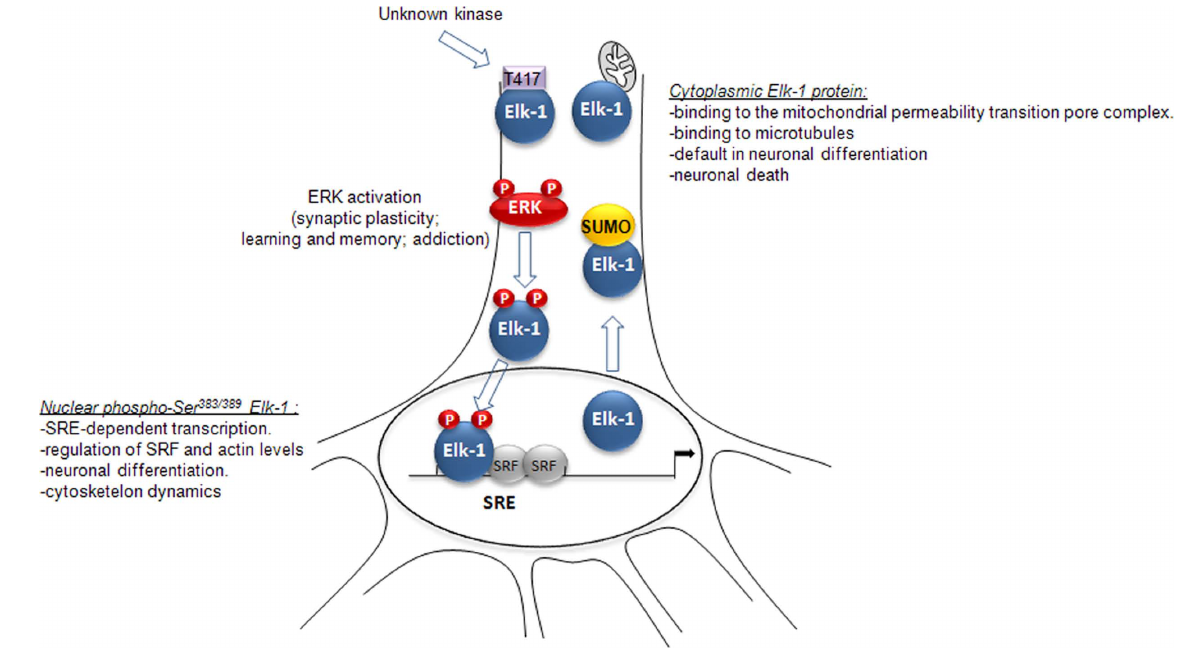
FiguRE 2 | Synthetic view of the impact of Elk-1 post-translational modifications on its cytoplasm-to-nucleus trafficking and functions in neurons (see main text for